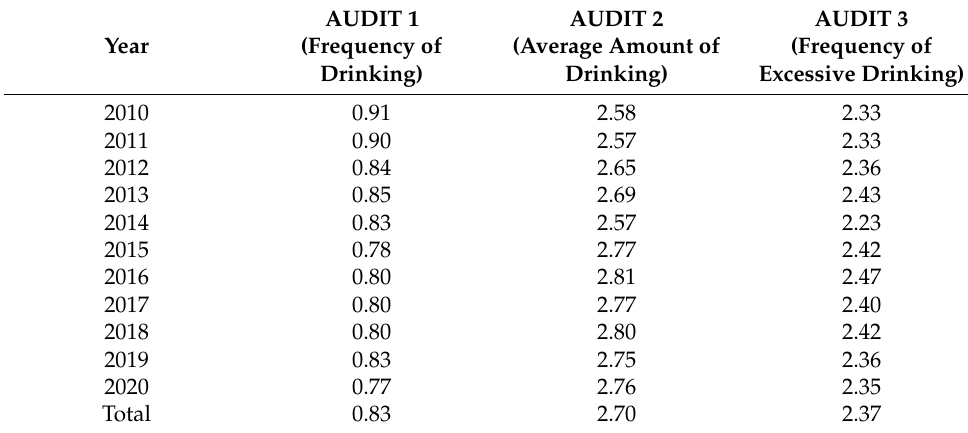
Table 3. Trend of the three AUDIT items from 2010 to